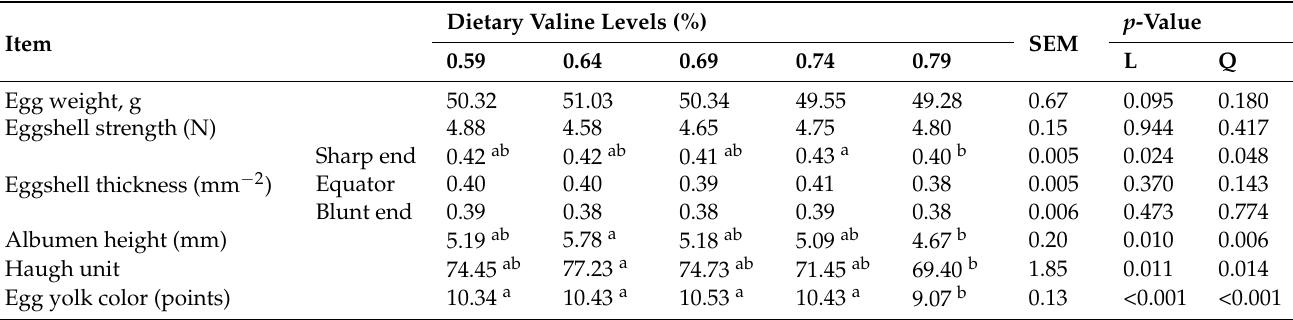
Table 4. Effects of dietary valine levels on egg quality of laying